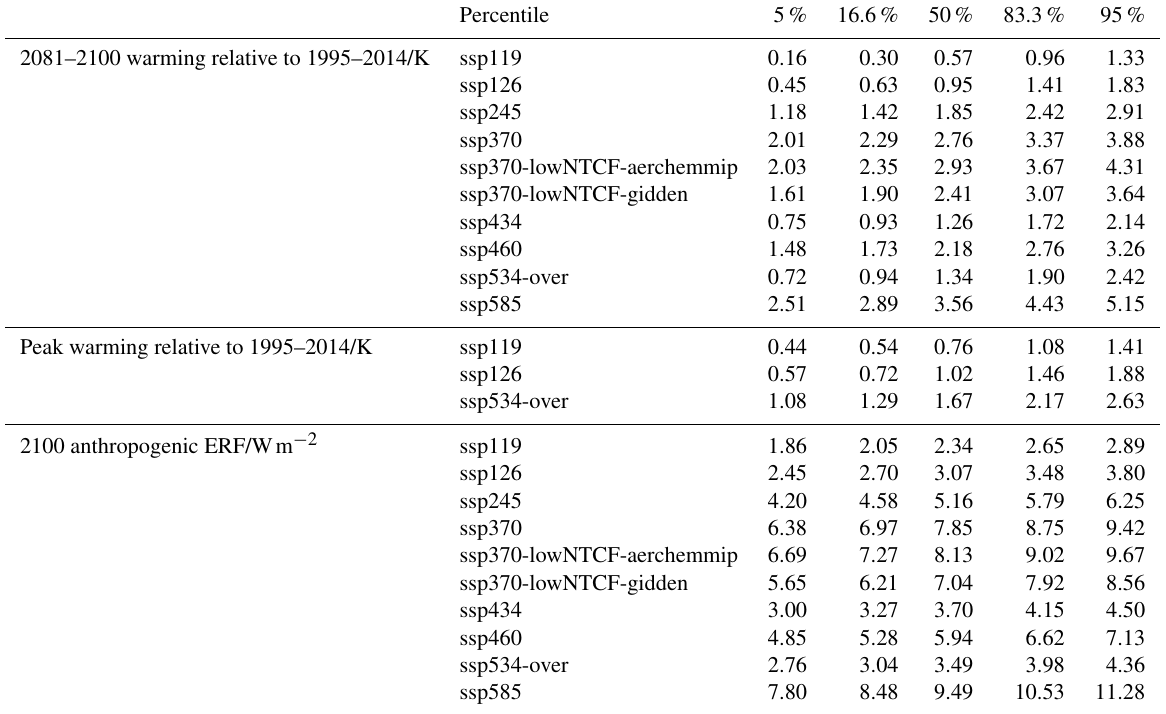
Table 10. Global warming and radiative forcing projections from the FaIRv2.0.0-alpha constrained ensemble under the SSPs. Table S6 in the Supplement displays these warming projections relative to a pre-industrial baseline of